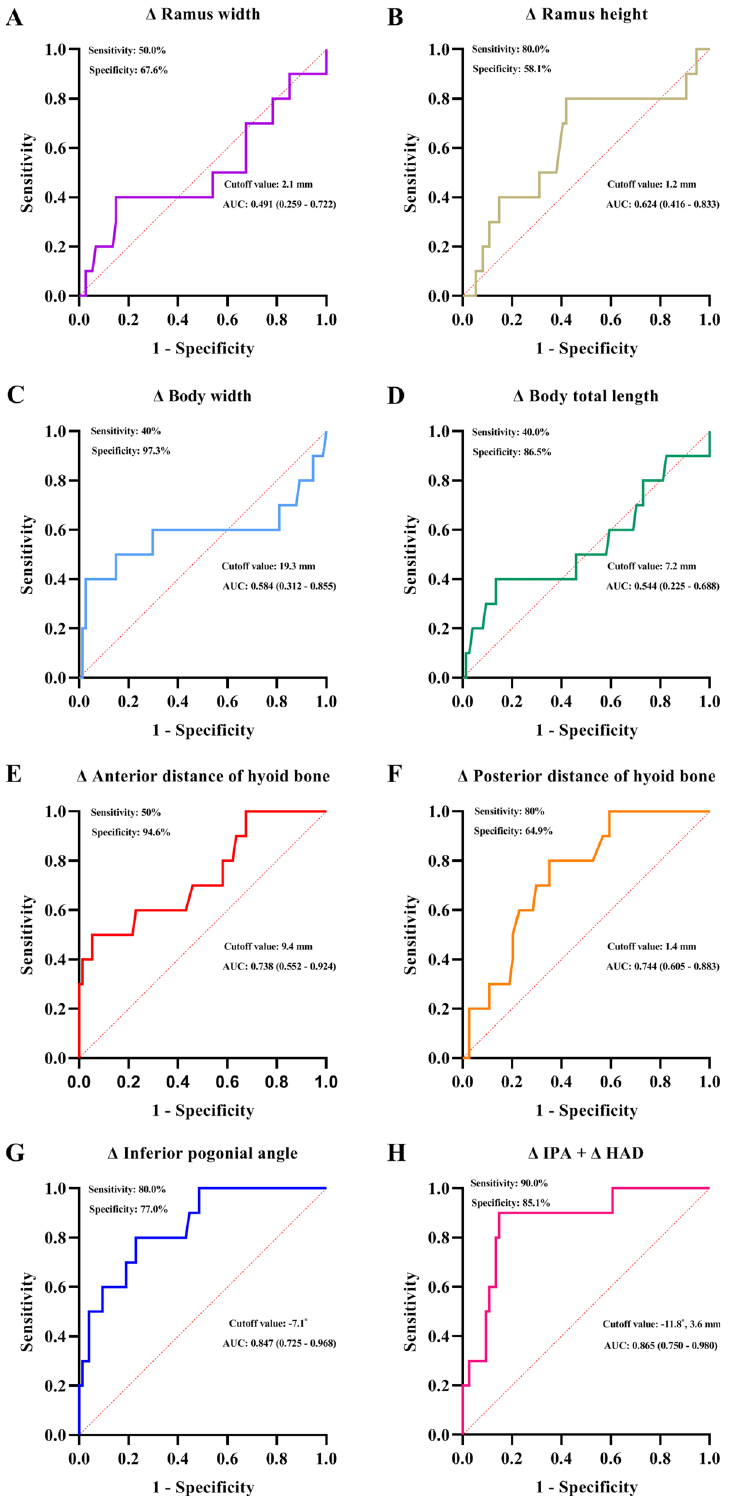
Figure 3. ROC curves for prediction of a difficult airway using ∆ramus width and height ( A , B ), ∆body width and the total length of the mandible ( C , D ), ∆anterior and posterior distance of hyoid bone ( E , F ), ∆ inferior pogonial angle (IPA), and ∆IPA plus ∆anterior distance of hyoid bone (HAD) ( G , H ). ∆ indicates the differences between estimated value according to the regression equation and measurement value of each